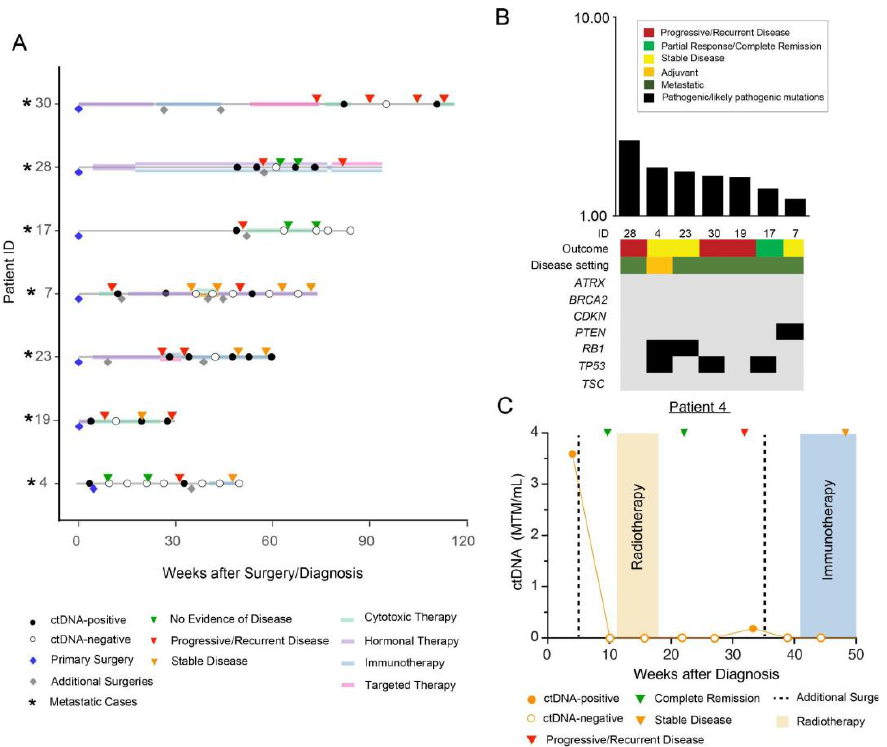
Figure 4. ( A ) Overview plot depicting the complete clinical course of all patients within sub-cohort D, including the results of longitudinal ctDNA analysis. Patients with metastatic disease are marked with an asterisk “*” symbol. Blue diamond reflects initial/primary surgery performed to build the personalized ctDNA assay, all other additional surgeries are represented with grey diamonds. ( A ) Distribution of pathogenic and likely pathogenic driver mutations across all 7 patients in sub-cohort